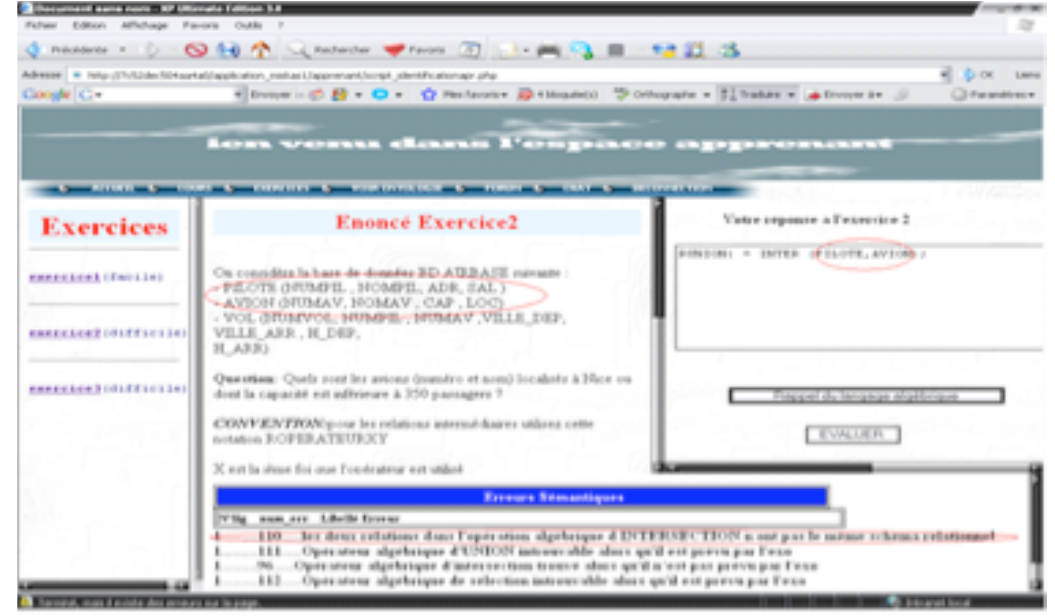
Fig. 4. This is the caption display of semantic errors with the RDB-E-LEARN